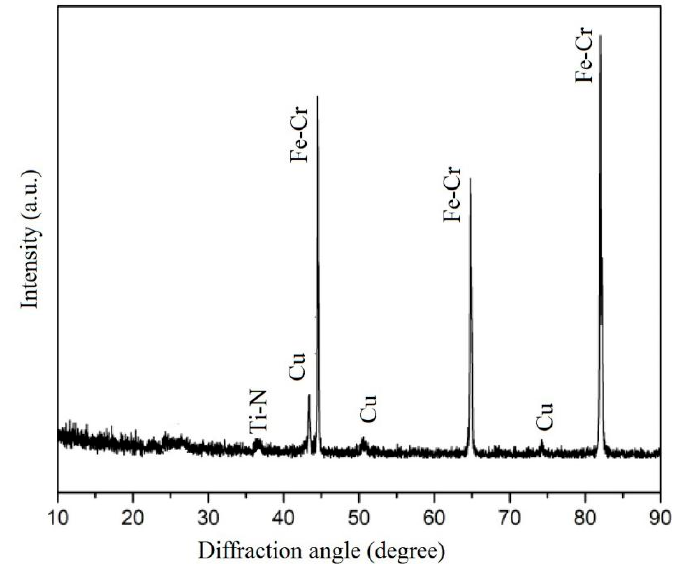
Figure 4. XRD 2 θ scan pattern of an as-grown Cu/Ti x Si y N/AlSiN on a stainless steel (SS) substrate.